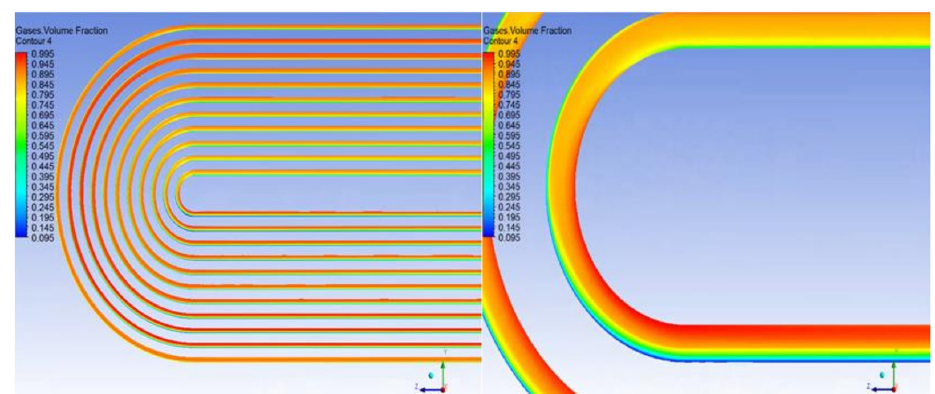
Figure 14. Gas volume fraction distribution in bend area of heat